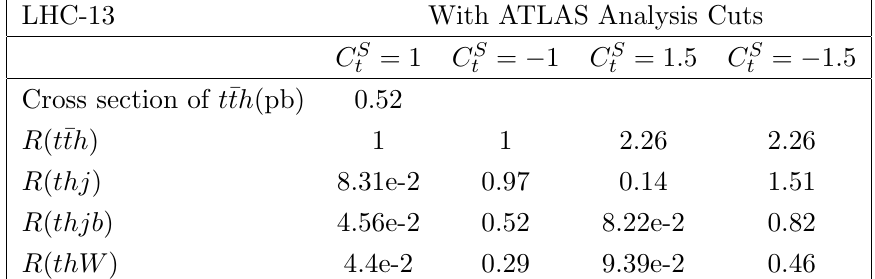
Table 11 . The cross-section ratios R ( t (cid:22) th ) and R ( thX ) with X = j; jb; W de(cid:12)ned in eq. (2.9). We p are taking s = 13 TeV (LHC-13) and C S